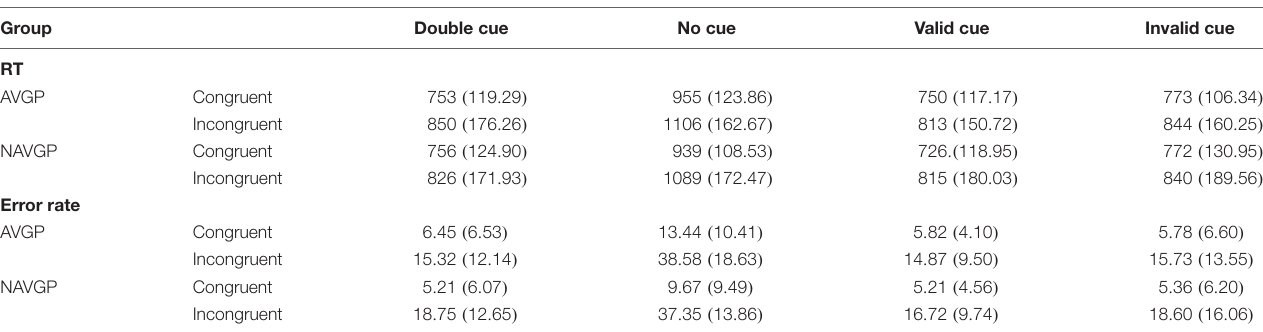
TABLE 5 | Mean (SD) reaction time (RTs, ms) and error rate (ER, %) for each condition in the ANT-A.